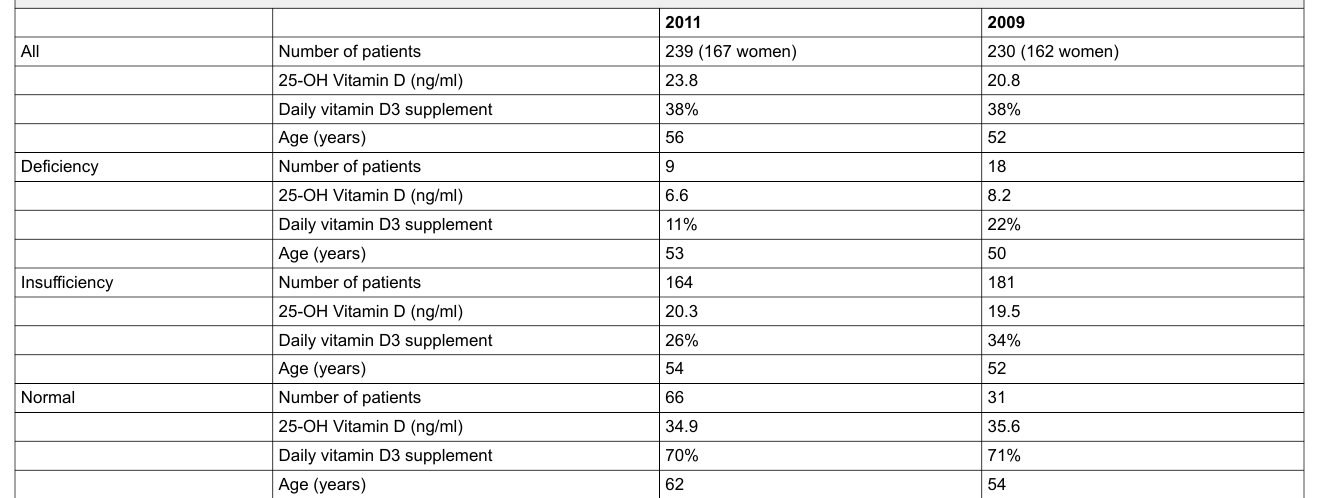
Table 1: Patients’ characteristics in 2009 and